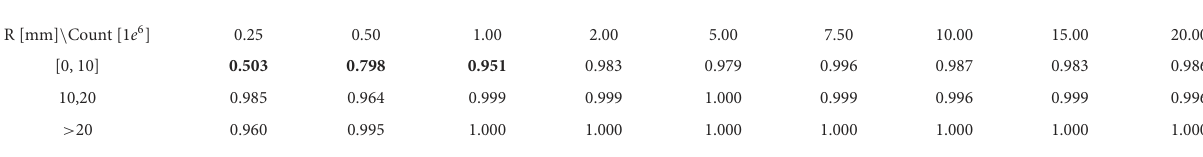
TABLE 2 The AUC value for lesions with different lesion size and true count level.